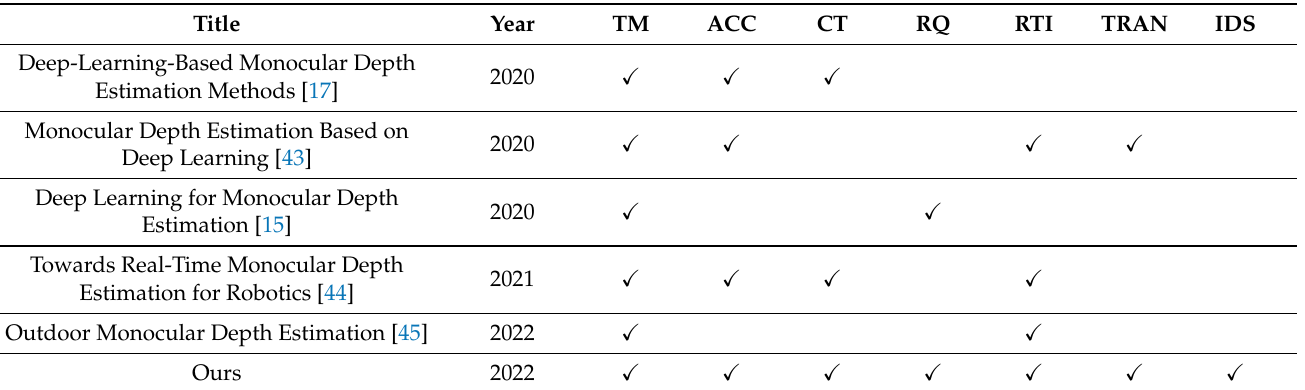
Table 1. Comprehensive to the related recent surveys in MDE in terms of six parameters;